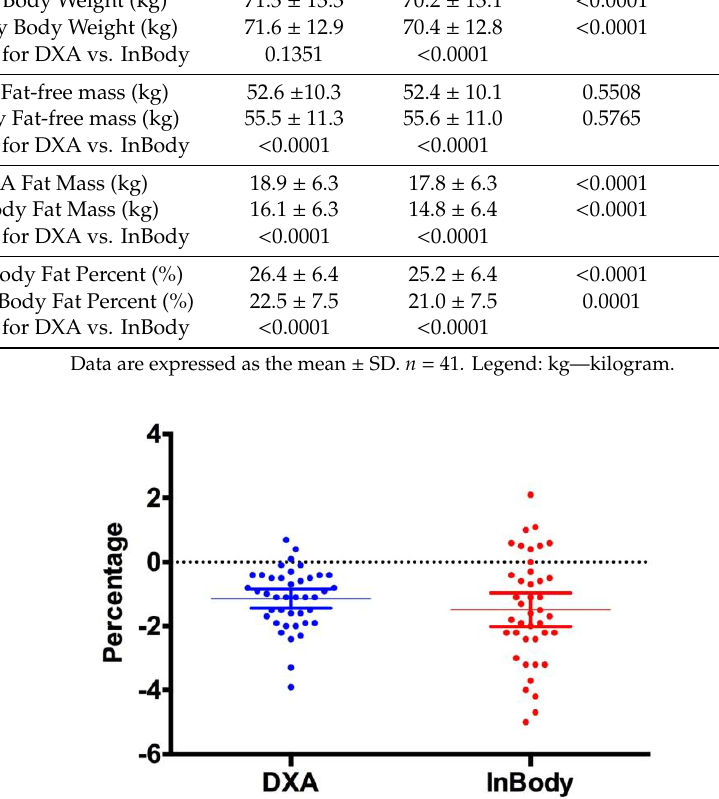
Figure 1. Change in Body Fat Percent. This figure shows individual data points comparing the DXA vs. InBody BIA. The data is presented as the mean (middle horizontal line) with a 95% confidence interval (CI). DXA: Lower 95% CI of mean − 1.437, Upper 95% CI of mean − 0.8457; InBody: Lower CI of mean − 2.016, Upper CI of mean −